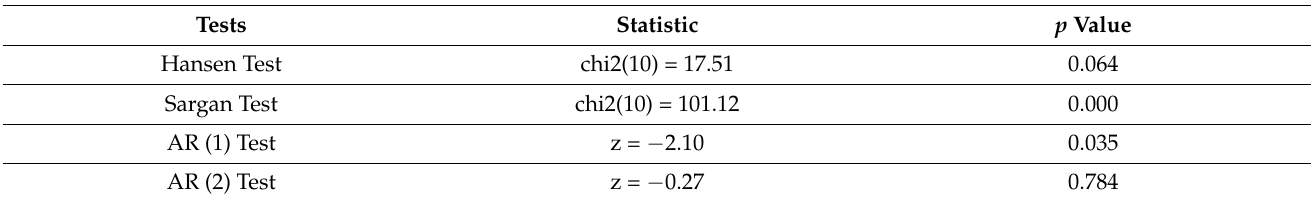
Table 7. Post-estimation